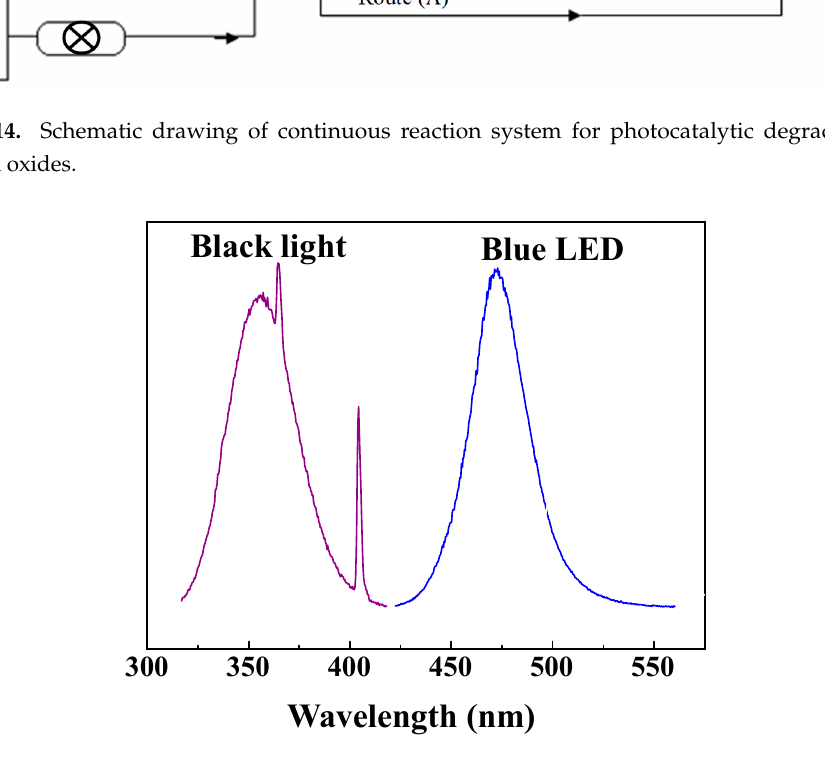
Figure 15. UVA lamp and LED photon energy distribution profiles (the visible-light region of UVA lamp is small and not shown in this figure).